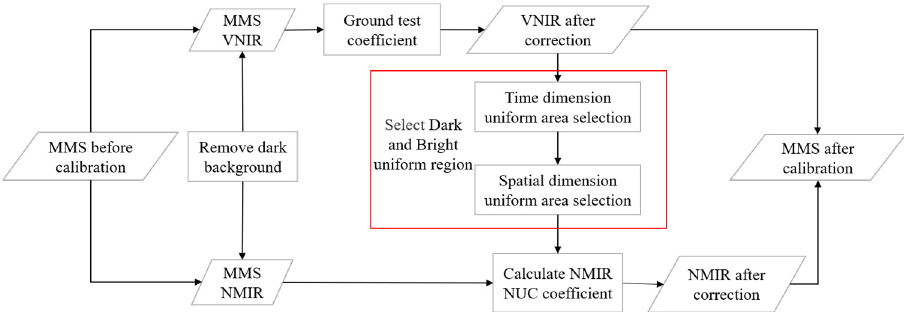
Figure 4. Non ‐ uniformity corrections process based on bright and dark uniform regions.